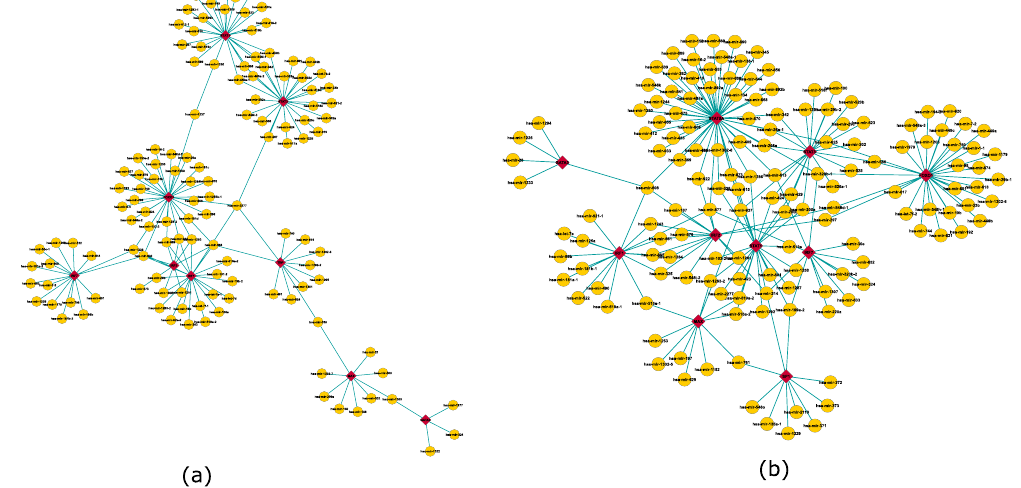
Figure 12. Tf-miRNA network. Here the red triangle shape nodes represent TFs identified from the differential coexpressed modules. The pink circle represent miRNAs regulated by those TFs in their upstream region (USR) (shown in panel (a)) and in downstream region (DSR) (shown in panel (b)).